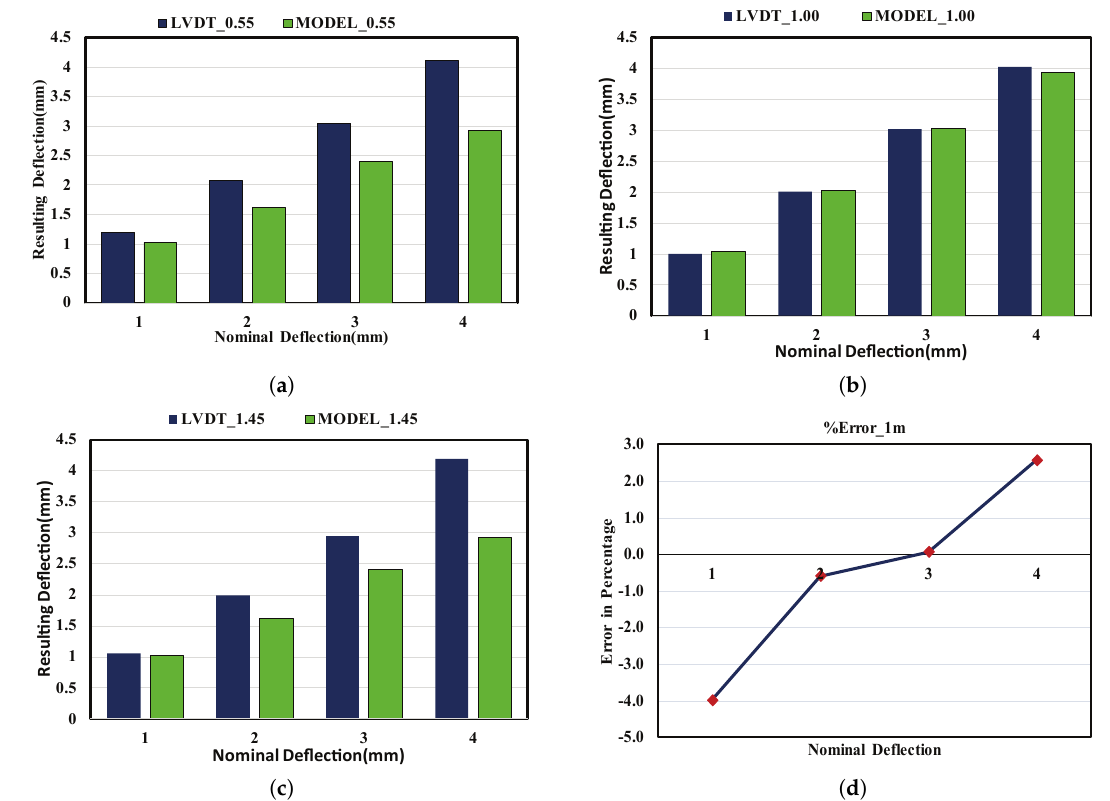
Figure 13. ( a ) model vs LVDT @ 0.55 m;( b ) model vs LVDT @ 1.00 m; ( c ) model vs LVDT @ 1.45 m; ( d ) Absolute Error for model at